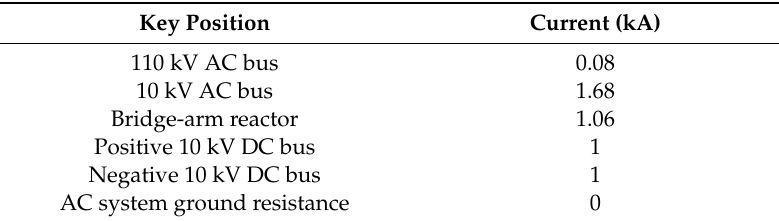
Table 4. Current levels in di ff erent areas during normal